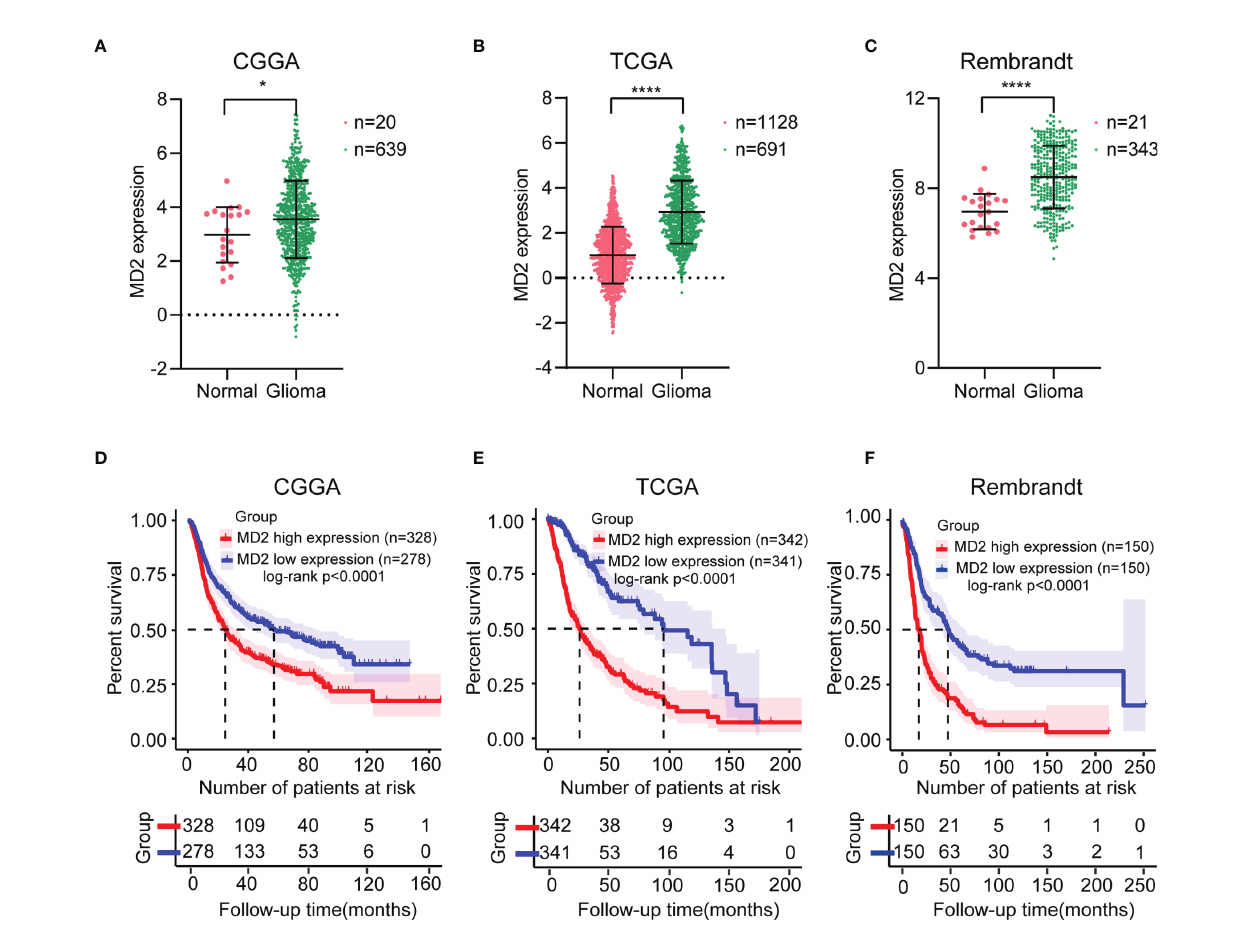
FIGURE 1 | The MD2 expression and survival analysis in gliomas. The mRNA expression differential analysis of MD2 in glioma patients in CGGA (A) , TCGA (B) and Rembrandt (C) databases. Kaplan-Meier survival plots of the associations of MD2 expression with glioma patient overall survival in CGGA (D) , TCGA (E) and Rembrandt (F) databases. * and **** indicate p < 0.05 and p < 0.0001,